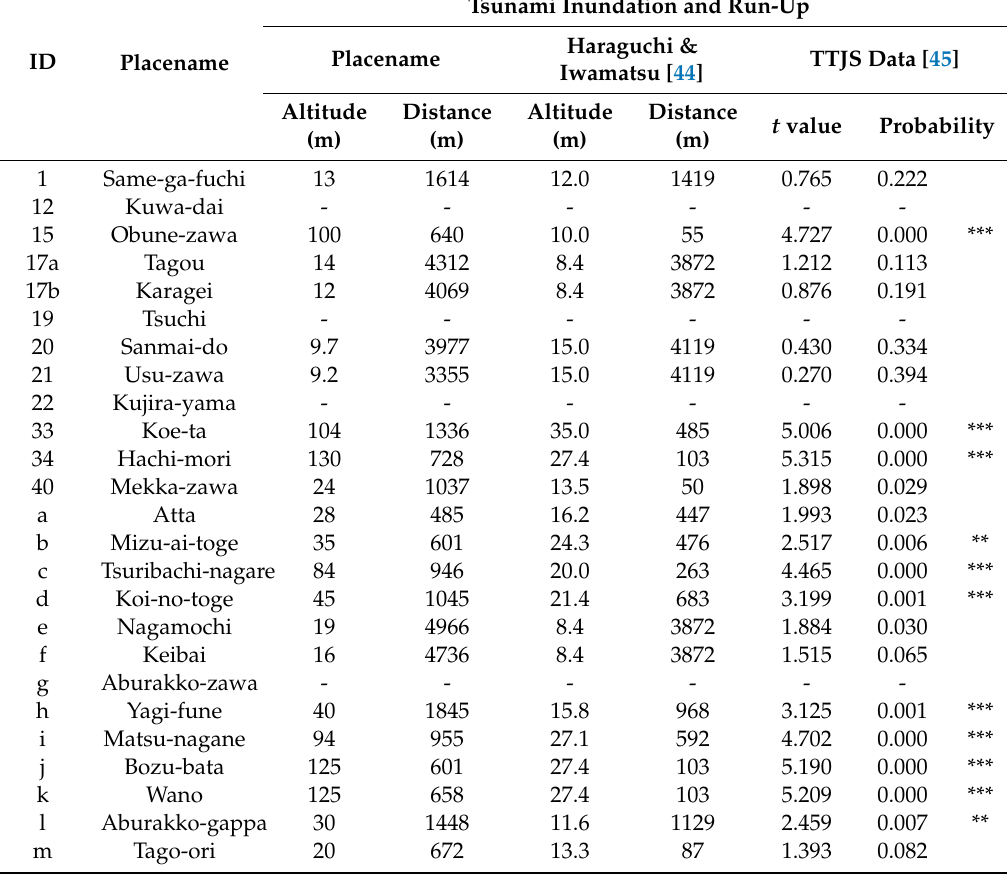
Table A1. Tsunami inundation and run-up values for Figure 1. The t values and the corresponding probability that Tsunami 2011 reaches the altitude and distance indicated by the placename is based on an empirical relationship in Appendix